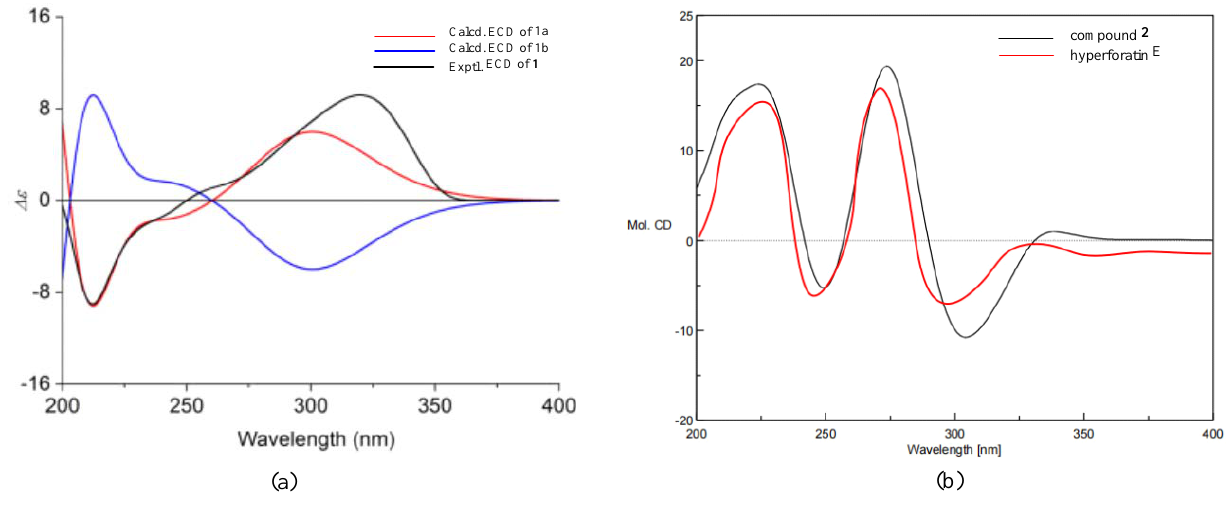
Figure 3. ( a ) Calculated and experimental ECD spectra of 1 . ( b ) The ECD spectra of 2 and hyperfo-